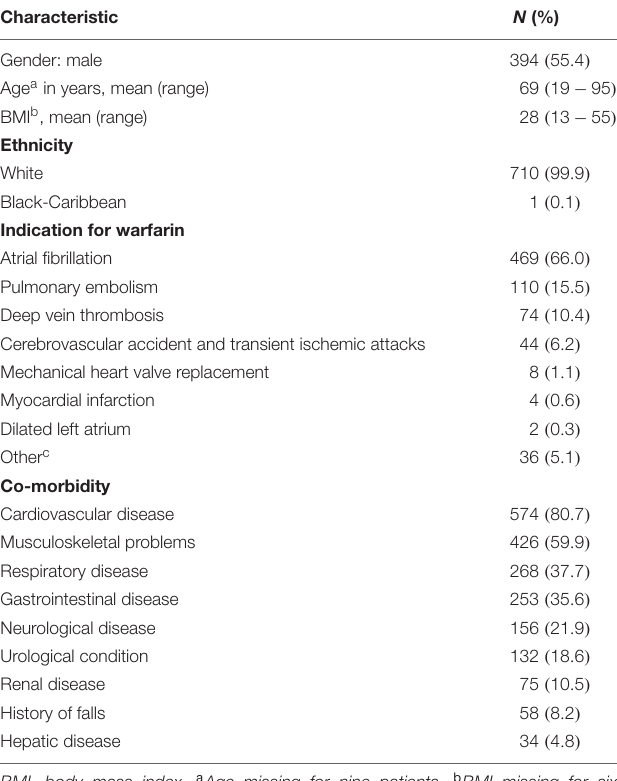
TABLE 4 | Clinical profile of 711 warfarin